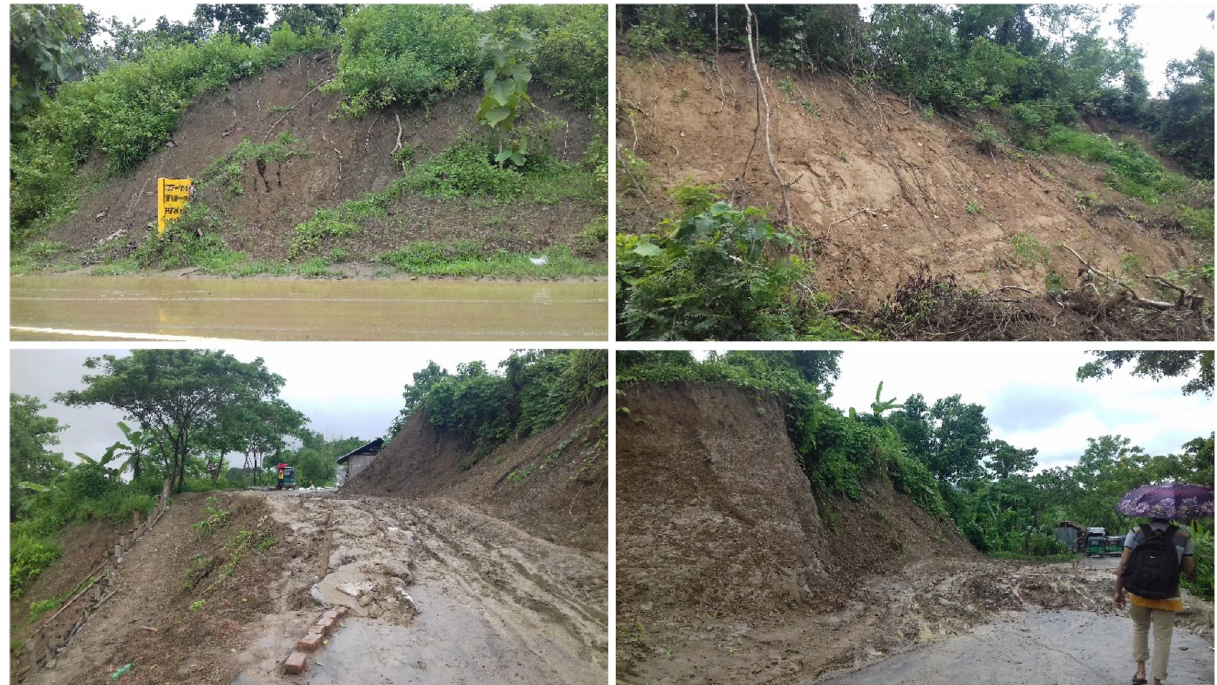
Figure 3. Pictures of some of the landslides in the study area (Pictures were taken by the Researchers during July 2017).